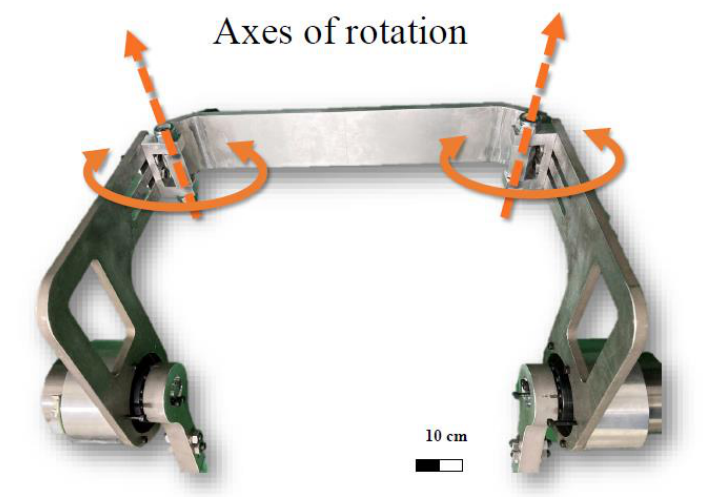
Figure 16. Front view of the LLRE-II waist.